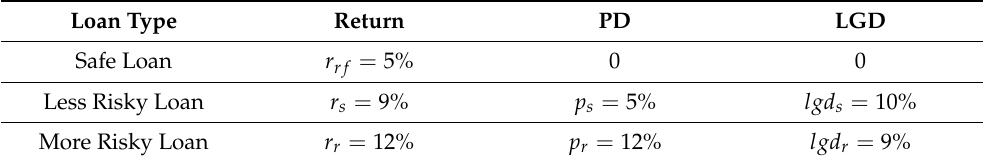
Table 4. Risk parameters for the three loans for the second example. Loan Type Return PD